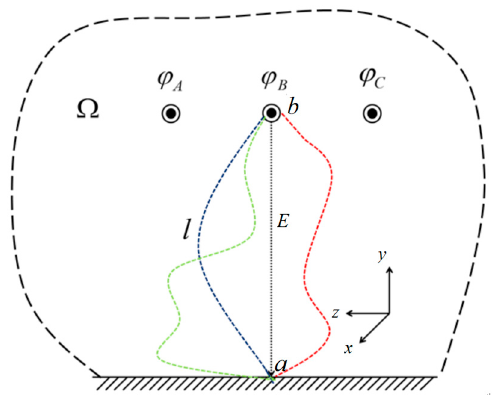
Figure 2. Space electric field composed by three-phase transmission lines.